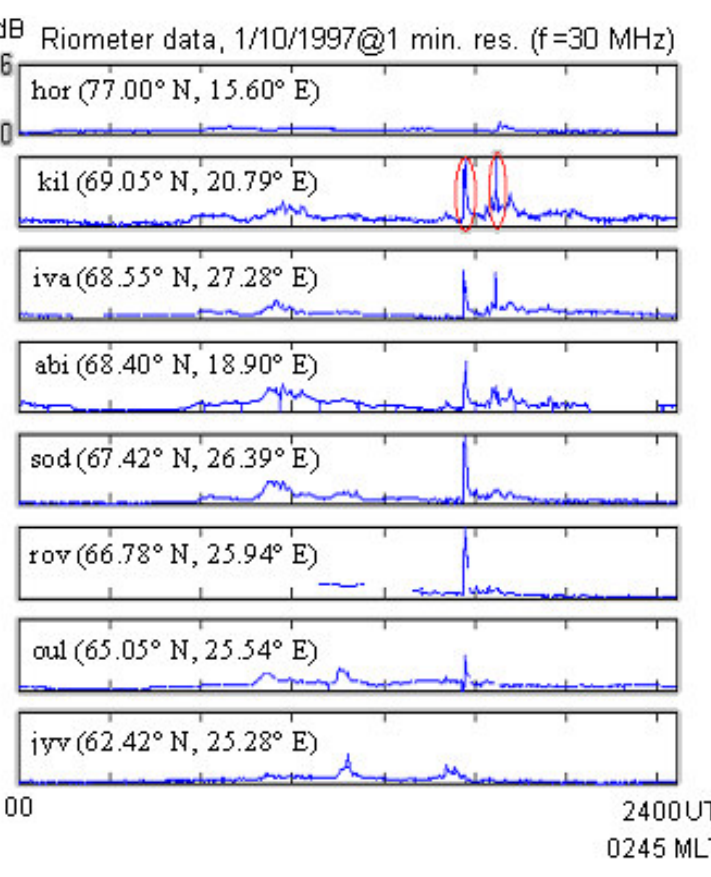
Fig. 9. Occurrence of spikes in SGO riometer chain for day 1 October 1997 00:00–24:00 UT (02:45 MLT) at 1-min resolution. Geographic latitude and longitude of stations are in brackets. The corrected geomagnetic (CGM) latitude of riometer stations at altitude of 90km are given in Table 2. Data is scaled between 0 and 6dB.